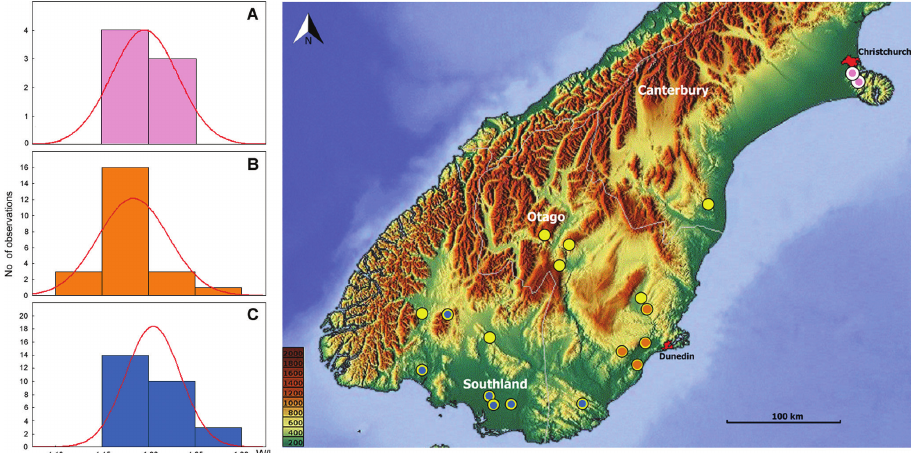
Figure 9. Variation in proportions of pronotum among different taxa and populations of Pelodiaetus . A – P. nunni ; B – P. sulcatipennis , mid-eastern populations; C – P. sulcatipennis , south-western popula- tions. Map of southern half of South Island, New Zealand, shows localities from where specimens were measured. Each species location dot (yellow or white) is identical to Fig. 8 but they are additionally marked with the appropriate bar graph color: pink, orange, and blue. X-axis values represent W/L – ratio of maximal width to length along the midline of pronotum. Red curve – expected normal distribution with sample mean and standard deviation. Elevation scale bars are given in